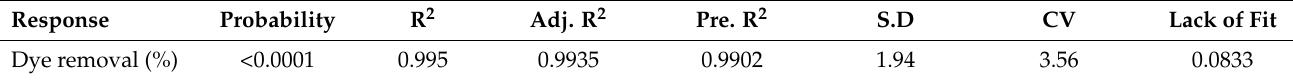
Table 5. ANOVA results of the predicted model.